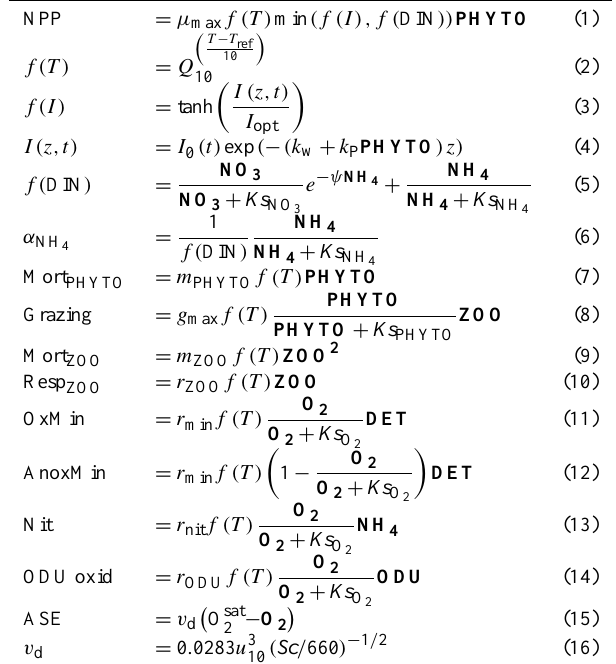
Table 6. Rate expressions of the pelagic ecosystem model, the state variables are in bold. Piston velocity ( v d ), air–sea exchange (ASE), Schmidt number ( Sc ), wind speed at 10m ( u 10